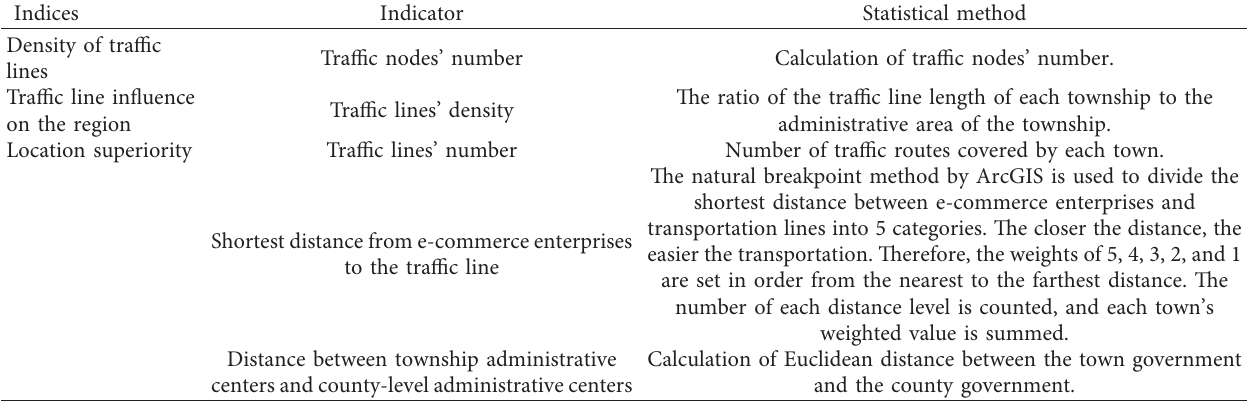
Table 1: Evaluation index system of transport superiority of Xiong’an New